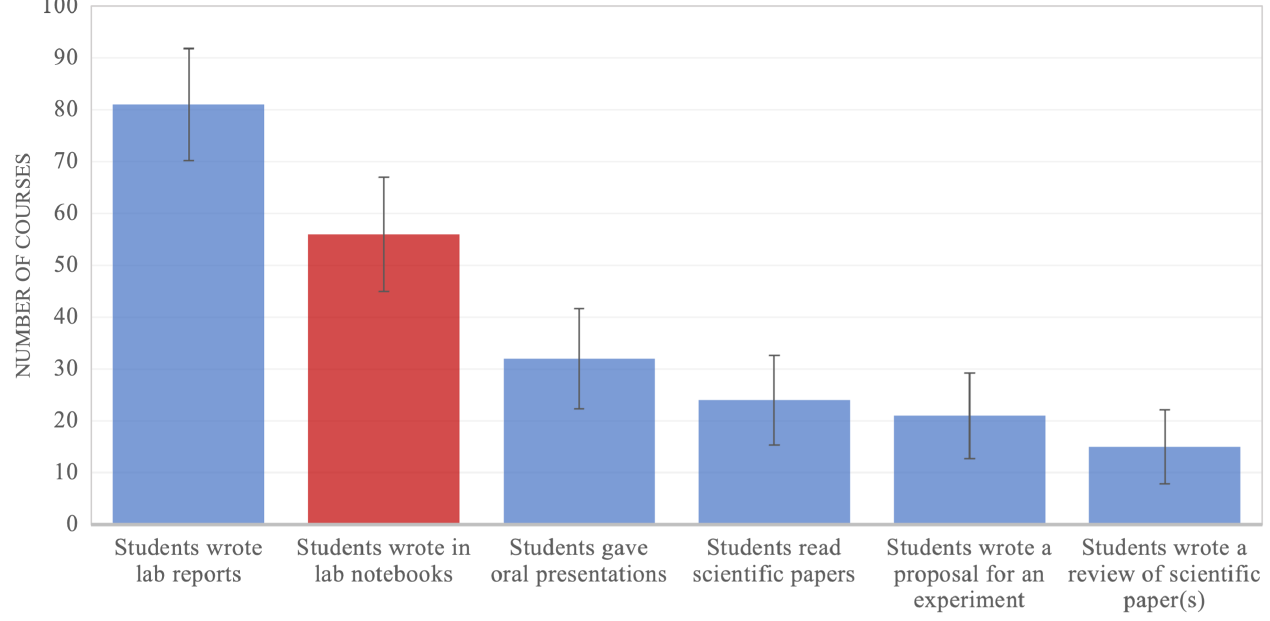
FIG. 8. Instructor reported scientific communication activities used after the transition to remote instruction in Spring 2020.